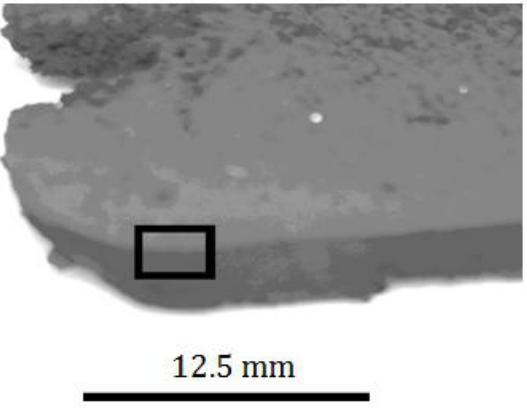
Figure 1. Carbon Nanofiber Network at increasing magnification, boxes indicate section